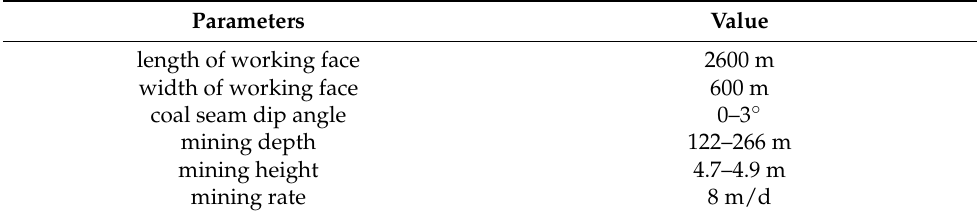
Table 1. Working face parameters and mining parameters.